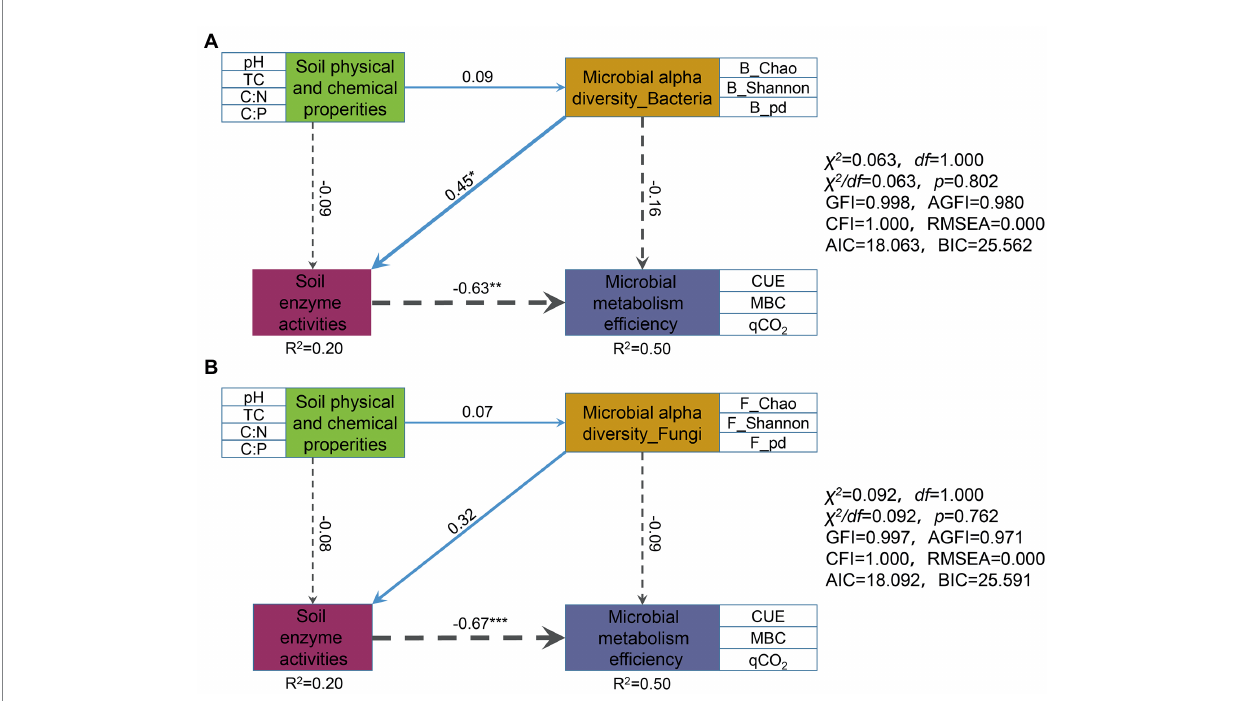
FIGURE 7 Effects of soil physicochemical properties, microbial alpha diversity, and soil enzyme activities on microbial metabolic efficiency directly and indirectly. The structural equation models (SEM) was constructed for bacteria and fungi respectively: (A) microbial alpha diversity_Bacteria; (B) microbial alpha diversity_Fungi. Blue solid and gray dotted arrows, respectively, represent positive and negative relationships. The wider the width of the arrow indicates the stronger the correlation. Numbers on arrows are standardized path coefficients. R 2 indicates the proportion of variance explained by predictors. * p < 0.05, ** p < 0.01, *** p < 0.001. The soil physical and chemical properties, microbial alpha diversity, and microbial metabolism efficiency were represented by the first component of the PCA performed in a multilayer